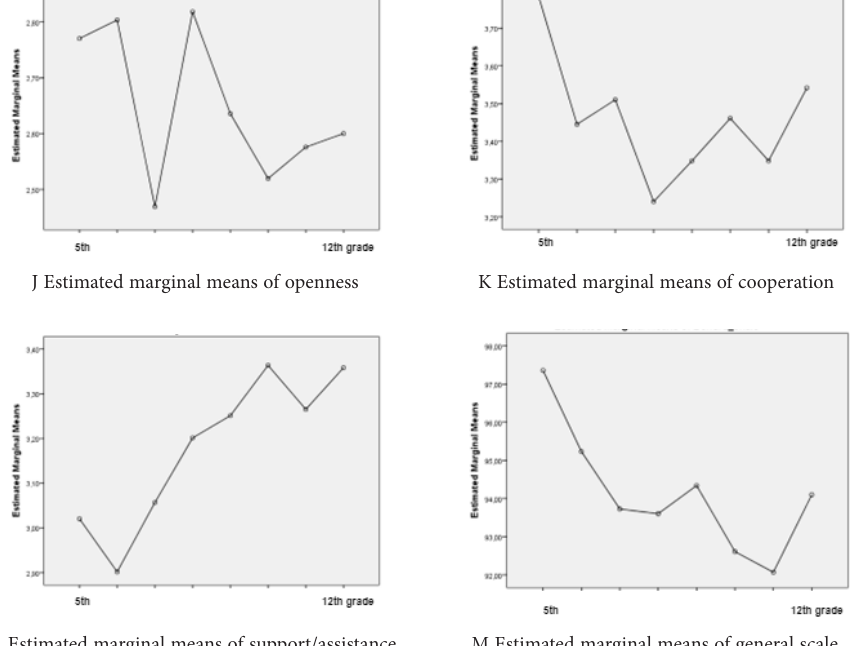
Figure 3. Evaluation of subscales of the general scale of socio-emotional competence in terms of the influence of different grades (n = 1322) (source: created by authors) The statistical representation of the data in the figures (A to M) shows the significant dif- ferences between the socio-emotional competences of children in different grades of those participating